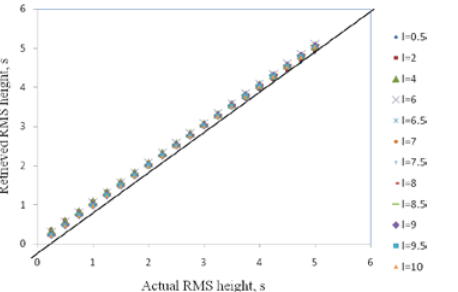
Figure 1. Scatter plot of retrieved RMS height vs actual RMS height,’ s ’.